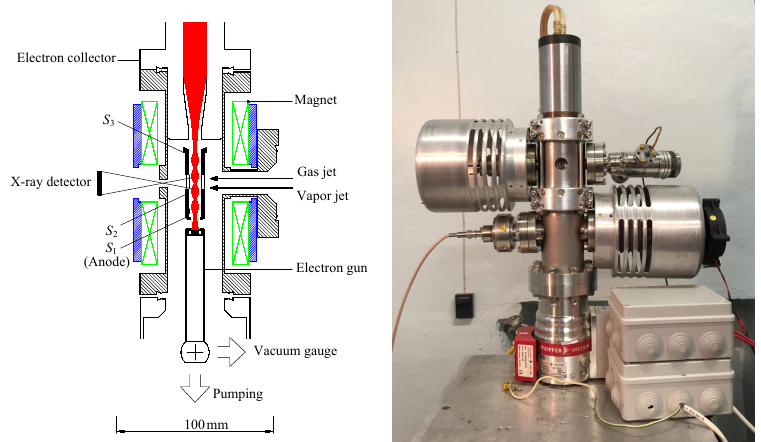
Figure 1. ( left ) Schematic of the present setup and electron-optical system; and ( right ) photo of the Dubna